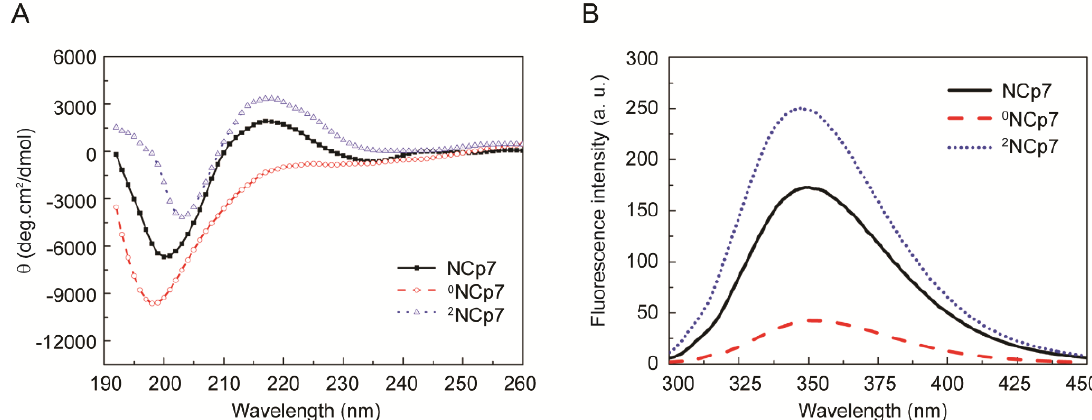
Figure 1. Comparison of 0 NCp7, NCp7 and 2 NCp7 in the secondary structure. ( A ) Circular dichroism spectra of 0 NCp7, NCp7 and 2 NCp7. ( B ) Fluorescence spectra of 0 NCp7, NCp7 and 2 NCp7.